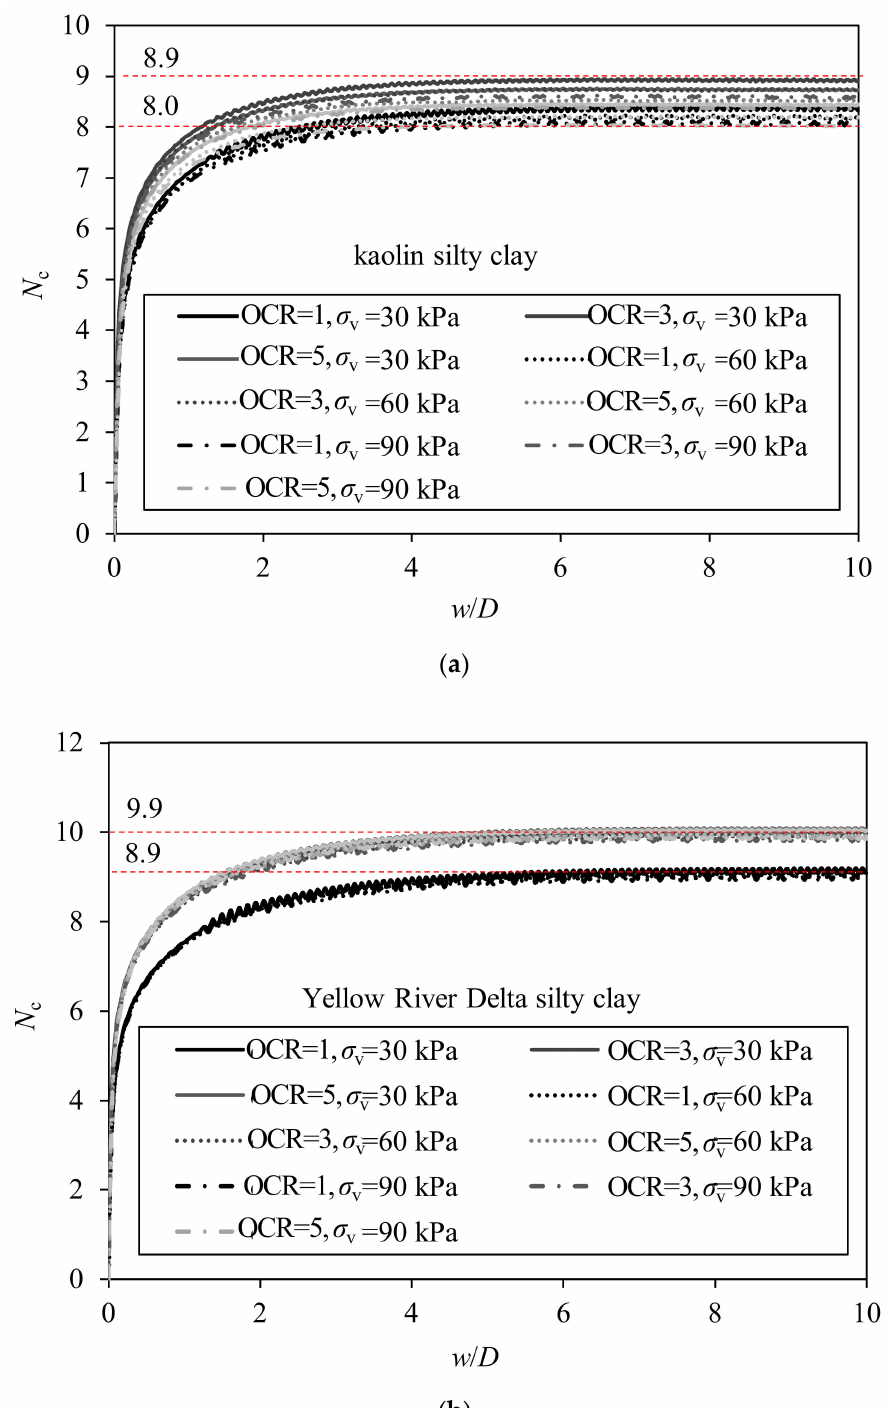
Figure 4. Cone resistance factor N c —normalized penetration depth curve. ( a ) Kaolin silty clay; ( b ) Yellow River Delta silty